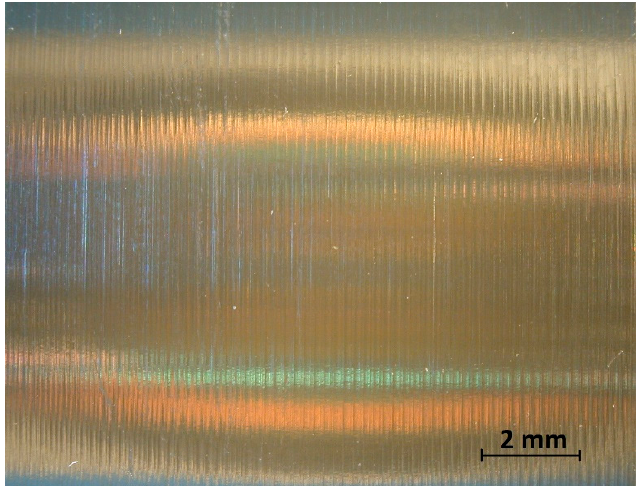
Figure 18. View of the machined surface after longitudinal turning without coolant (23 HRC).